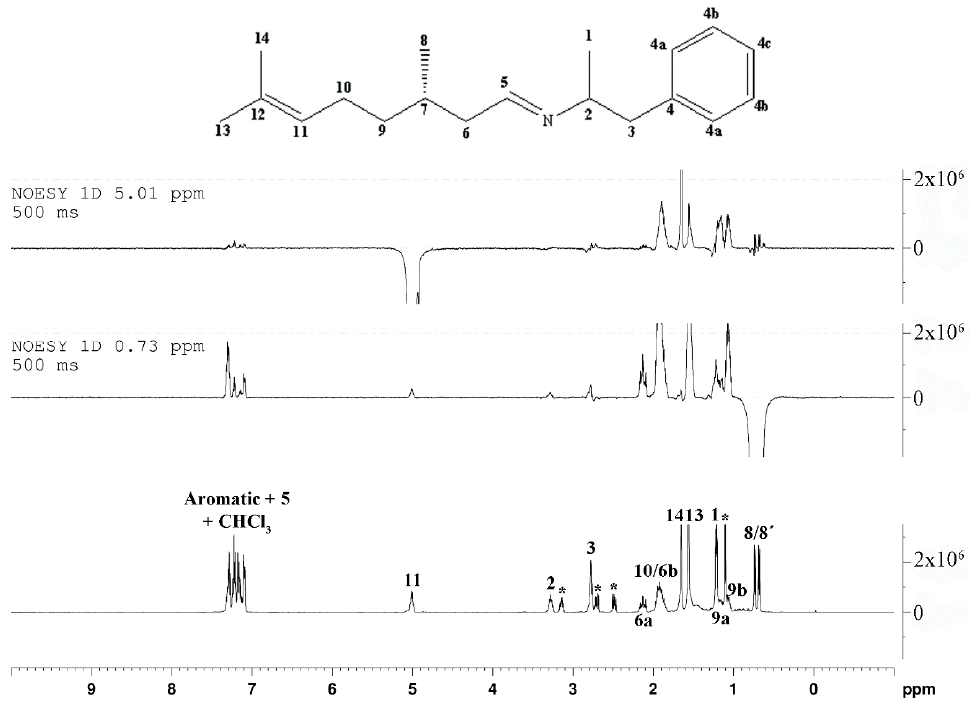
Figure 6. NOE experiment for an equimolar mixture of the diastereoisomers ( S,S and S,R ) of imine 7 at a mixing time of 500 ms. The signals indicated by asterisks are due to unreacted amphetamine. Irradiated at 5.03 ppm (H11) and 0.73 ppm (H8).